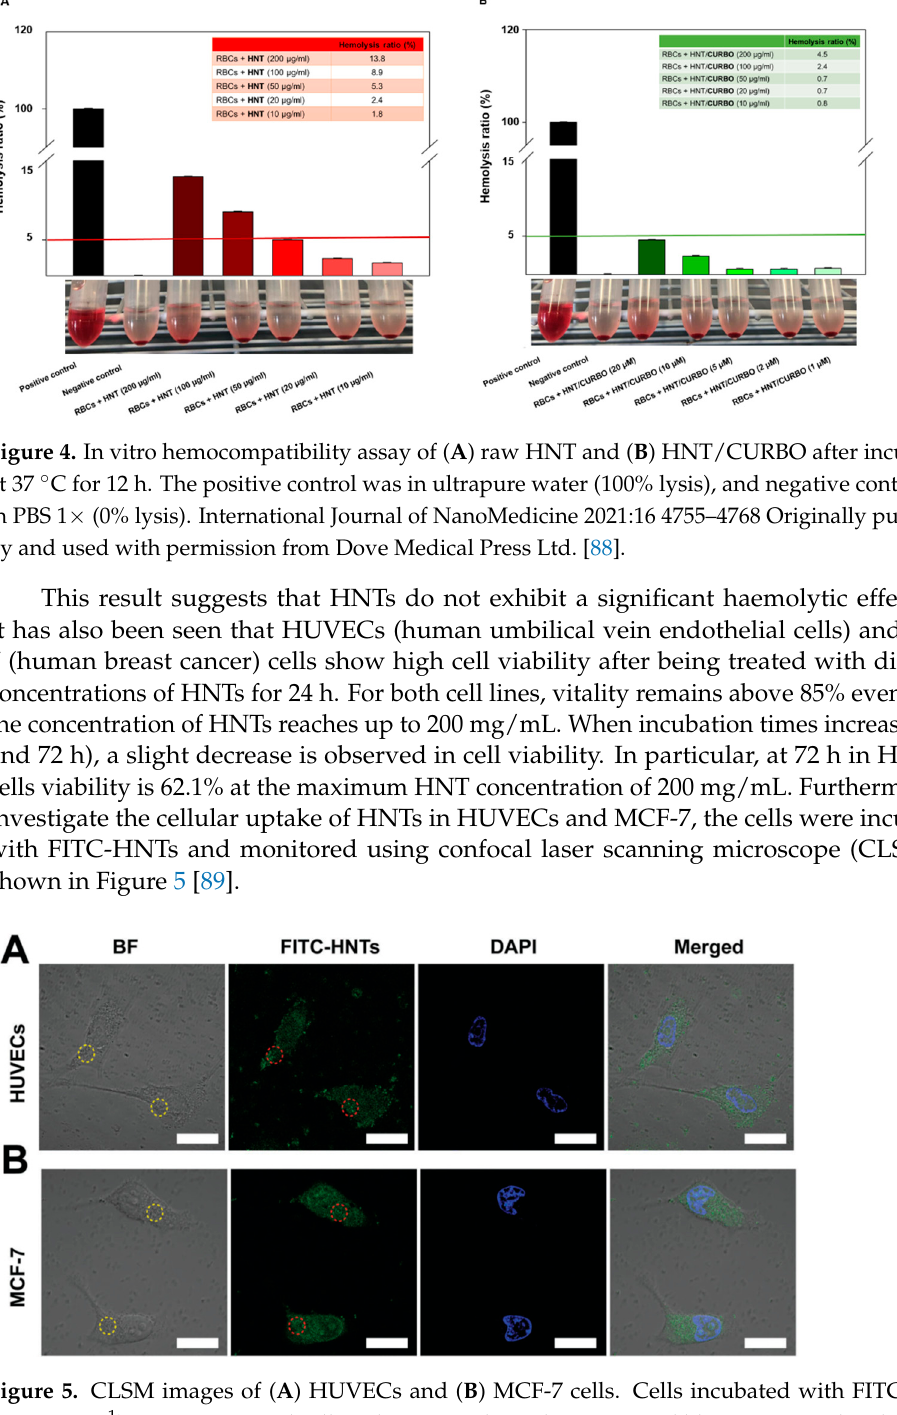
the percent survival of zebrafish embryos and larvae have no significant changes at dif- ferent developmental stages (24, 48, 72, 96, and 120 hpf) except at the highest concentra- tions (25 and 50 mg/mL) (Figure 6).